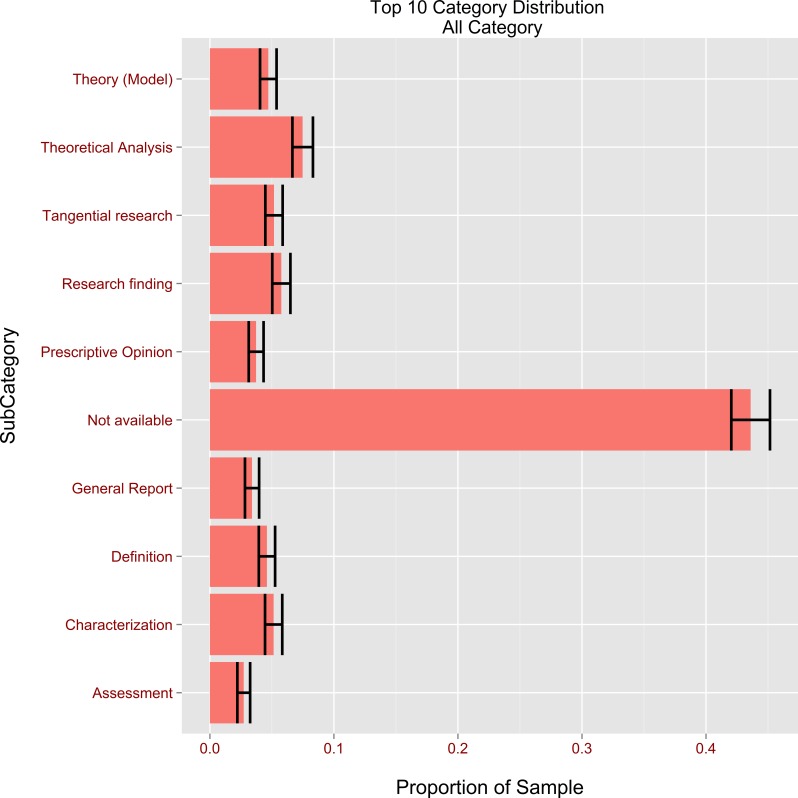
Proportion of the top 10 citation categories with confidence bars across all databases.